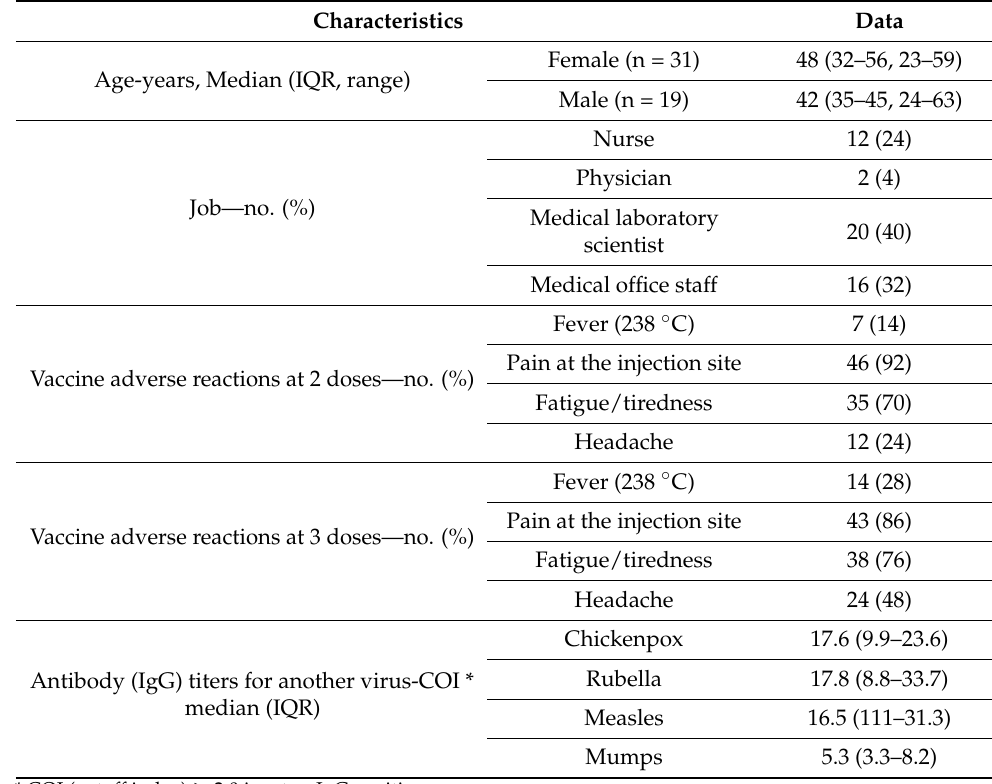
Table 1. Characteristics of the health workers participating in this study.